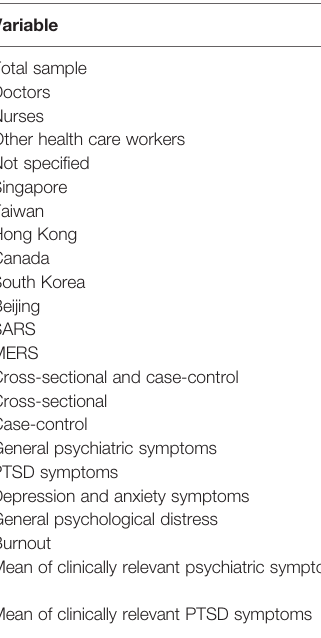
TABLE 2 | Summary of descriptive statistics of studies included ( N = 15).